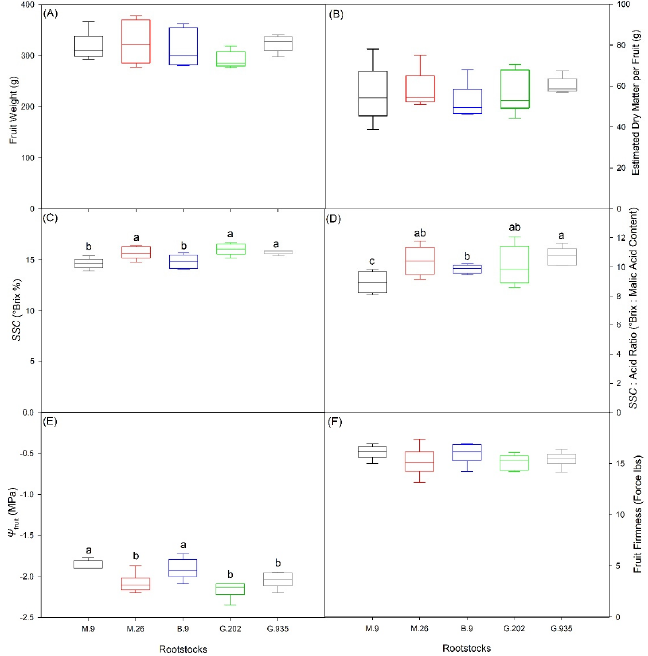
Figure 6. Fruit weight ( A ), dry matter weight ( B ), soluble solid contents SSC ( C ), SSC : acidity ratio ( D ), water potential of fruit hypanthium Ψ fruit ( E ), and fruit firmness ( F ), of Ambrosia TM apples on five rootstocks in the second-year planting. Different letters in each sub-panel stand for significant differences amongst rootstocks ( P ≤ 0.05, ANOVA, Fisher LSD pairwise comparisons), whereas the absence of letters stands for no significant difference. In ( A , B ): n = 6, and each replication consisted of 5 fruits; in ( C , D ): n = 6, and each replication consisted of the juice of 6 fruits; in ( E , F ): n = 6, and each replication consisted of 4 fruits.